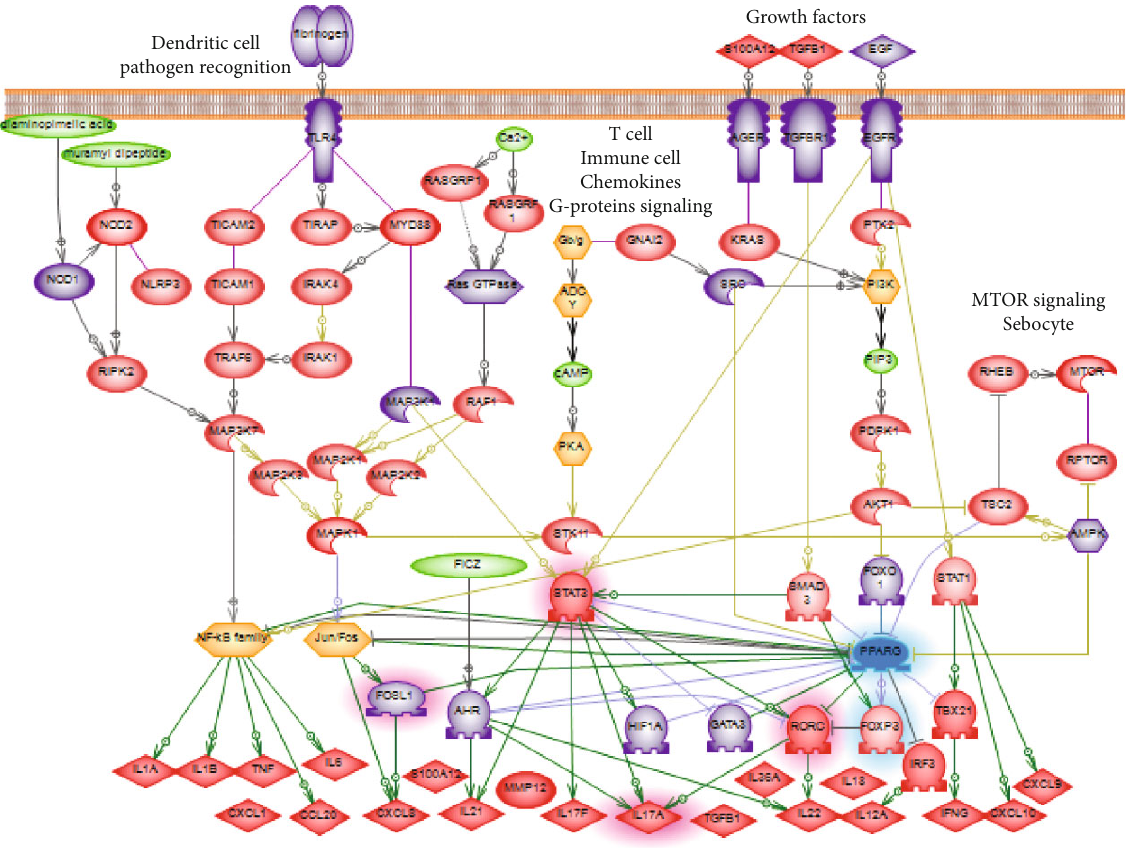
Figure 4: Model of downregulated PPAR γ signaling in psoriasis. PPAR γ which expression is downregulated in psoriasis is colored blue. Regulators that may inhibit the expression of PPAR γ (data based on PPI and pathway functional analysis) are colored in violet. Targets which may be overexpressed in psoriasis due to the decrease of the negative impact of PPAR γ are colored in bright red. FOXP3 , STAT3, IL17A, RORC , and FOSL1 are highlighted according to own experiments (read section “ Preliminary analysis of PPAR γ signaling in human psoriatic skin ” ). Downexpressed genes ( PPAR γ and FOXP3 ) are highlighted in blue, and overexpressed genes are highlighted in